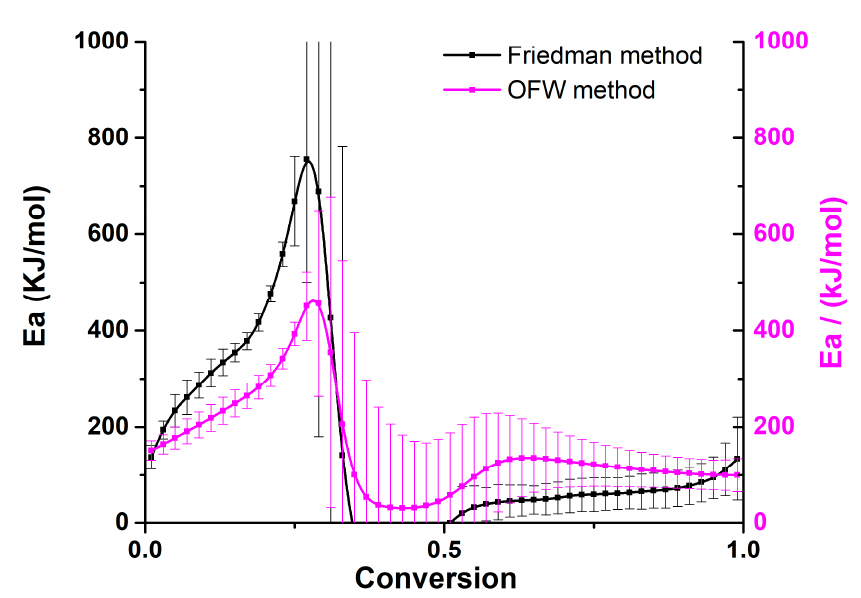
Figure 11. Activation energies calculated using Friedman analysis (black) and the Ozawa − Flynn − Wall method (magenta) under 2%